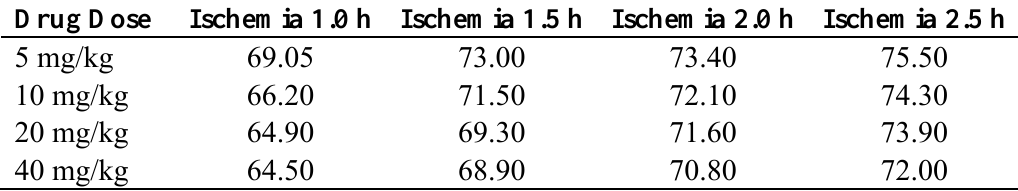
Table 2. The infarction volume of tetrazolium chloride (TTC)